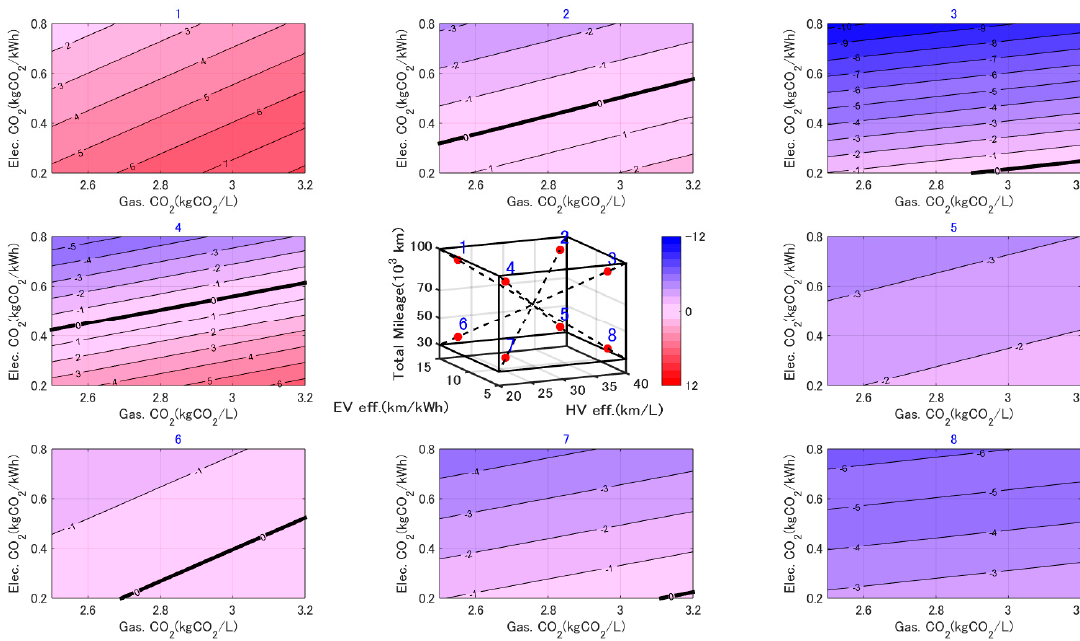
Figure 6. Five-dimensional diagram of comprehensive LCCO 2 comparison between HV and EV with difference of vehicle CO 2 emissions during production ∆ D set to 4000 kg.